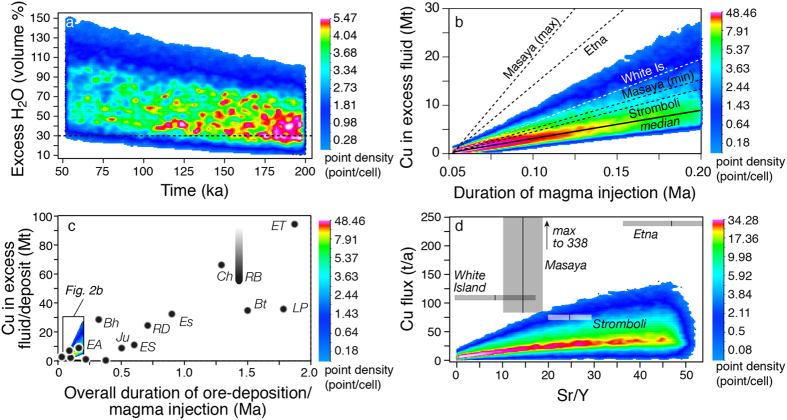
Excess H2O, metal budget, temporal and geochemical parameters of porphyry Cu deposits and passively degassing volcanoes.(a) Monte Carlo simulations of volume % of excess H2O in magmas accumulated under a high flux rate (0.016 km3/a) between 6 and 10 km depth versus duration of magma injection parameterized from ref. 20. Different colours indicate variable point densities in our simulations as shown by the scale bar on the right-hand side; (b) Cu (Mt) in excess fluid versus duration of magma injection for the high flux rate (0.016 km3/a) scenario. The continuous black line is the median value of the Cu emission rate of our simulations. The dashed black lines are projections of average Cu emission rates from passively degassing volcanoes (Etna29, Masaya30, White Island31, Stromboli32); (c) Cu (Mt) in porphyry copper deposits versus overall duration of the ore deposition periods (black dots) compared to the Cu (Mt) liberated by excess fluids of Fig. 2b during magma accumulation with a high magma flux (0.016 km3/a). The black dots representing porphyry Cu deposits are shaded to indicate that uncertainties exist on the determinations of both Cu endowments and overall duration of the ore deposition periods (see text). Cu endowment of Rio Blanco is much higher (up to >200 Mt Cu) if the whole district is taken into account (represented by shaded projection towards high Cu endowment). For abbreviations of PCD see Table S1.1; (d) Cu flux (tons/year) versus Sr/Y ratios of the four passively degassing volcanoes of Fig. 2b compared to our model simulations. Sr/Y values are averages from the georoc database (http://georoc.mpch-mainz.gwdg.de/georoc/) ±1σ uncertainties.